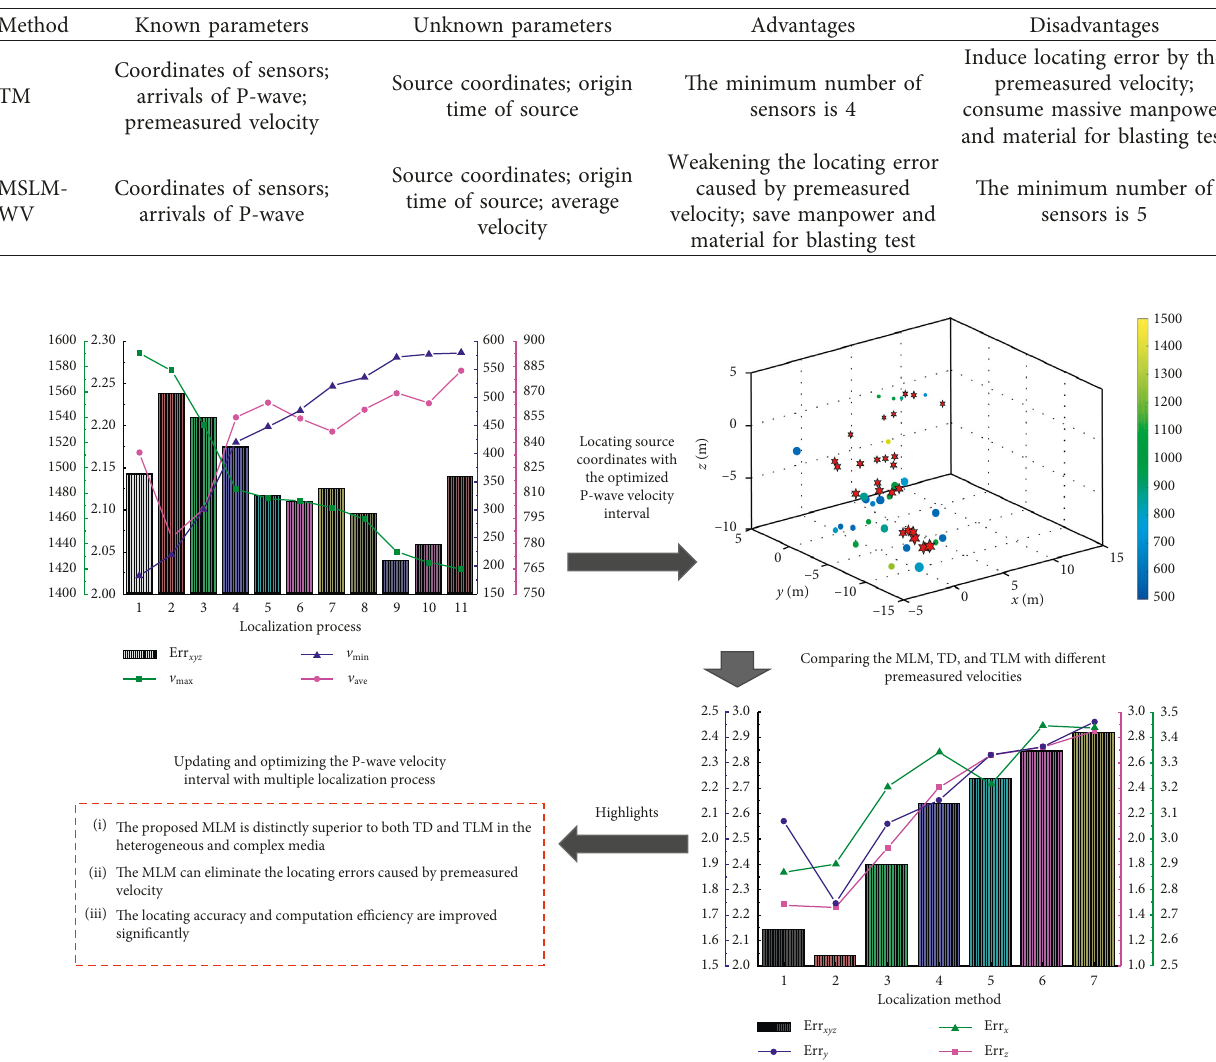
Figure 5: Multistep localization method (MLM) for locating sources in the heterogeneous and complex media. Through the continuous narrowing and optimization for P-wave velocity interval, the optimal localization results with higher accuracy can be solved successfully. Based on the field test, as well as the comparison between MLM, TD, and TLM, it can be proved and concluded that MLM is superior to other two methods and has higher locating accuracy and computation efficiency (from [81]).